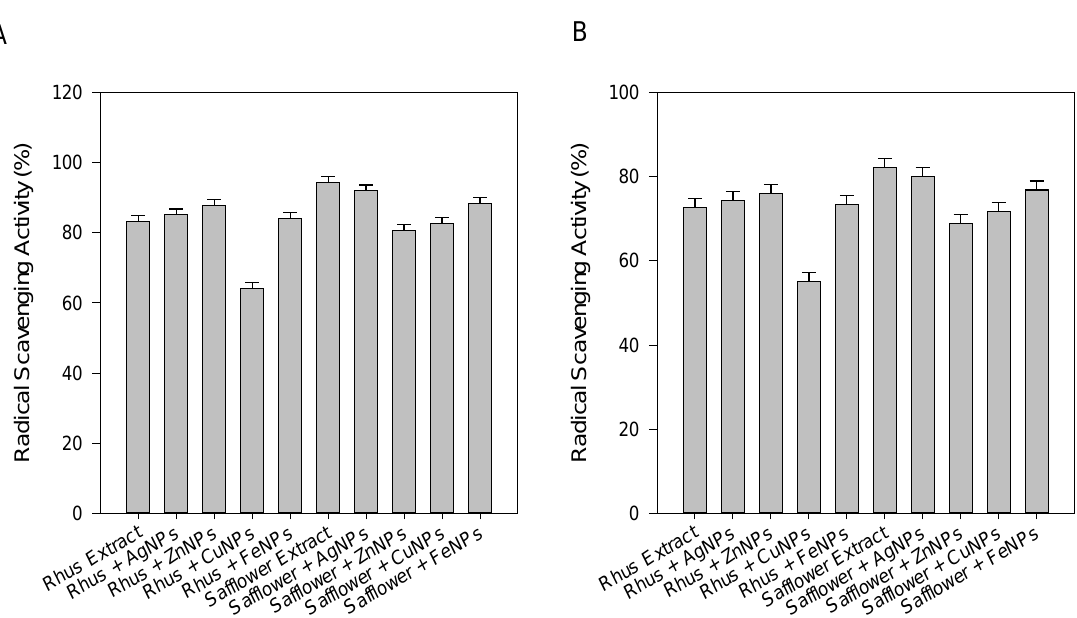
Figure 5. Comparison between the antioxidant results. ( A ) DPPH and ( B ) ABTS •+ of plant extracts and their synthesized nanoparticles at 35 µg/ mL.